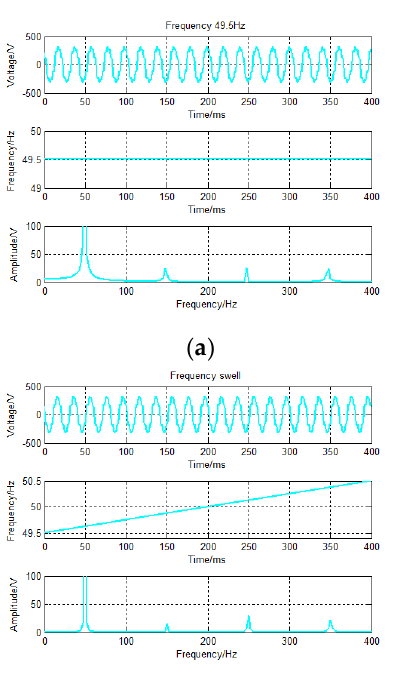
The sampling cycle is selected to be 0.00004 s. The experiment sampling voltage Figure 11. Experiment platform and Schematic diagram. ( a ) Experiment platform. ( b ) Schematic diagram of the programmable power supply.